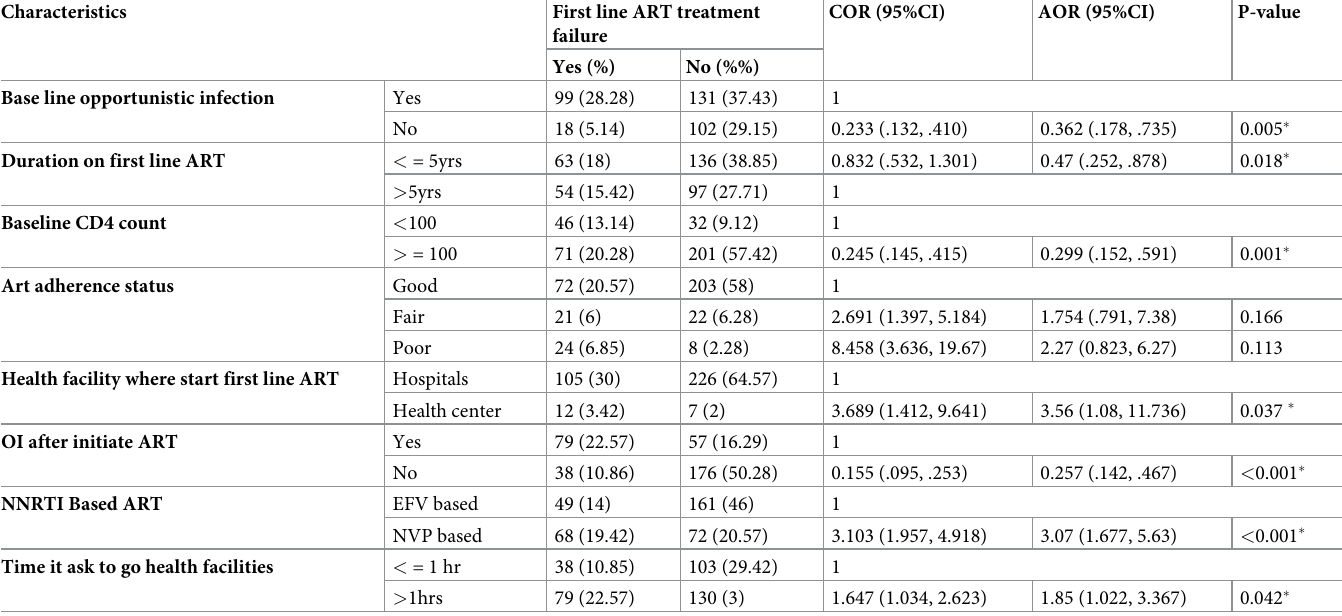
Table 5. Multivariable analysis of predictors of first line ART treatment failure.